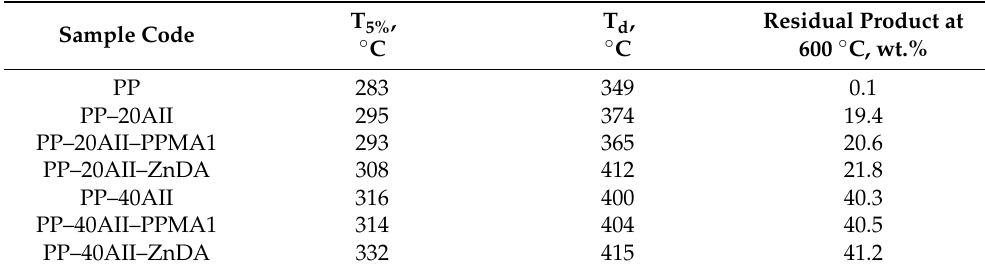
Table 2. Thermal parameters of PP and PP – AII composites as determined by TGA (under air).